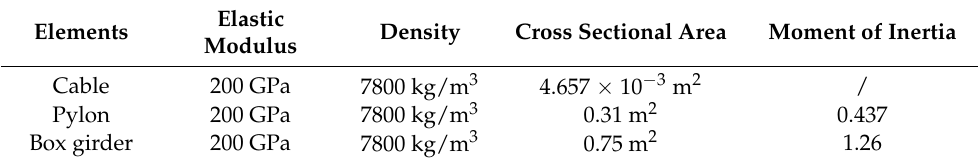
Table 1. Physical parameters of the single tower cable-stayed bridge. Elastic Density Cross Sectional Area Elements Modulus